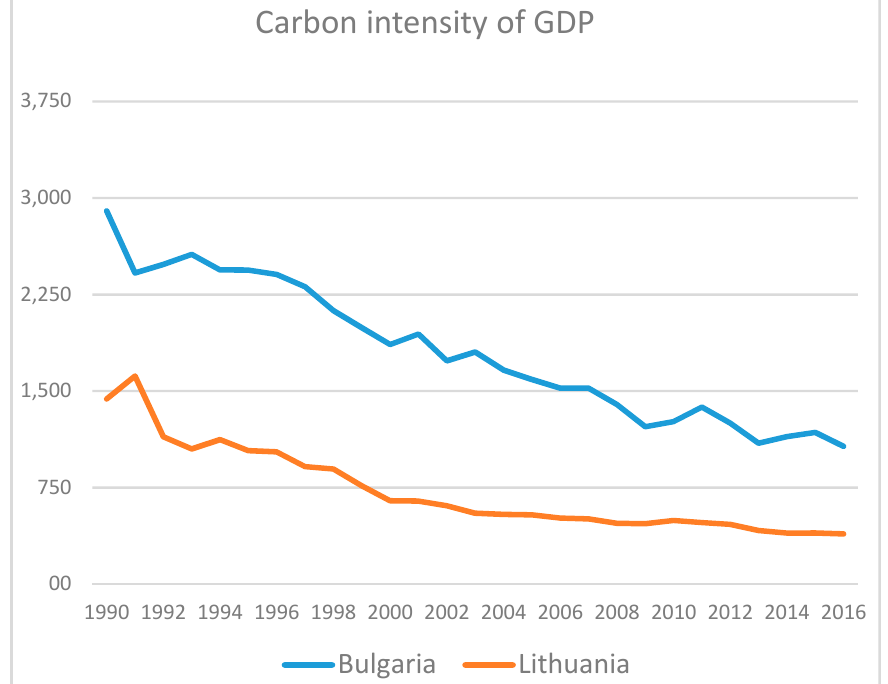
Figure 6. GHG emission per GDP in Bulgaria and Lithuania, CO 2 eq/M€'10. Source: [39,40].